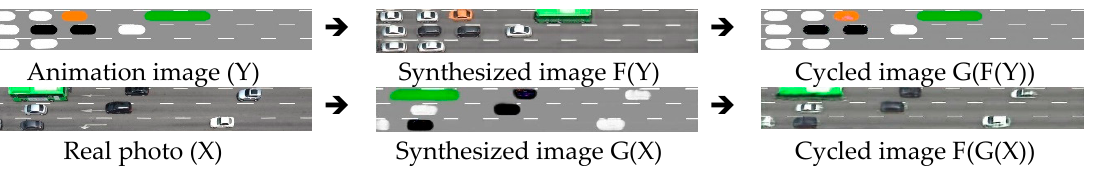
Figure 11. Mapping examples of CycleGAN.